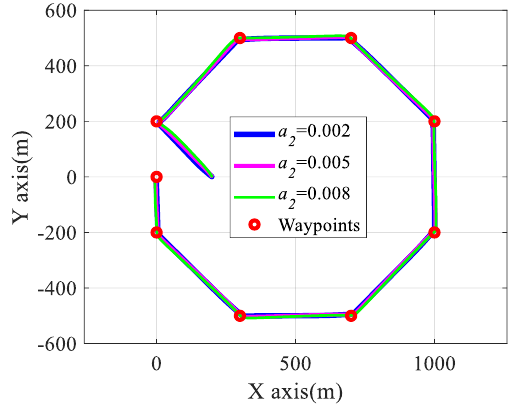
Figure 14. Tracking courses: waypoint-tracking scenario with respect to di ff erent control gains a 2